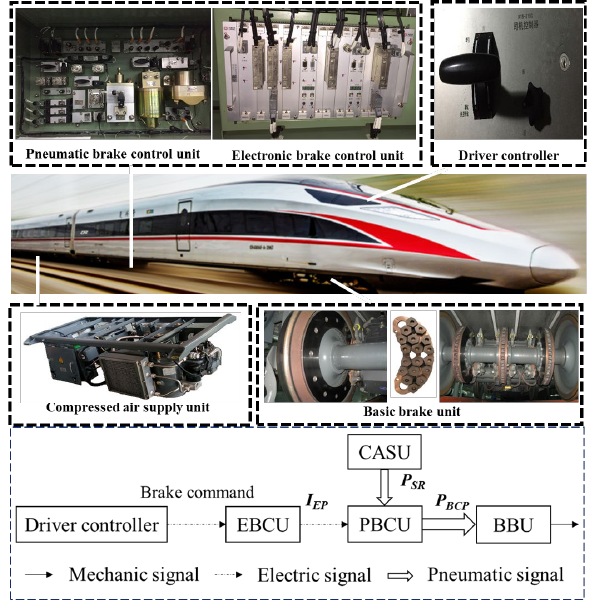
Figure 1. Schematic diagram of the brake system of trains.